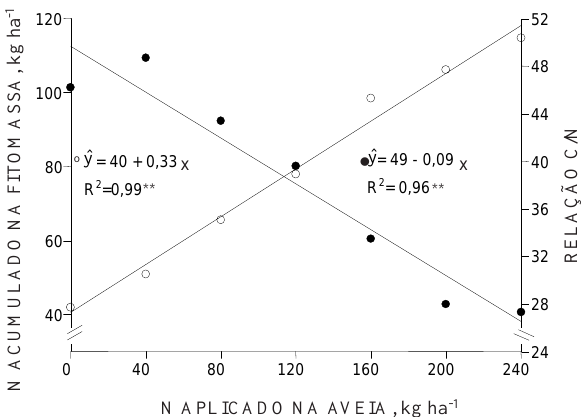
Figura 2. Quantidade de N acumulado e relação C/ N da parte aérea da aveia preta de acordo com as doses de N aplicadas, na média dos anos de 1998 a